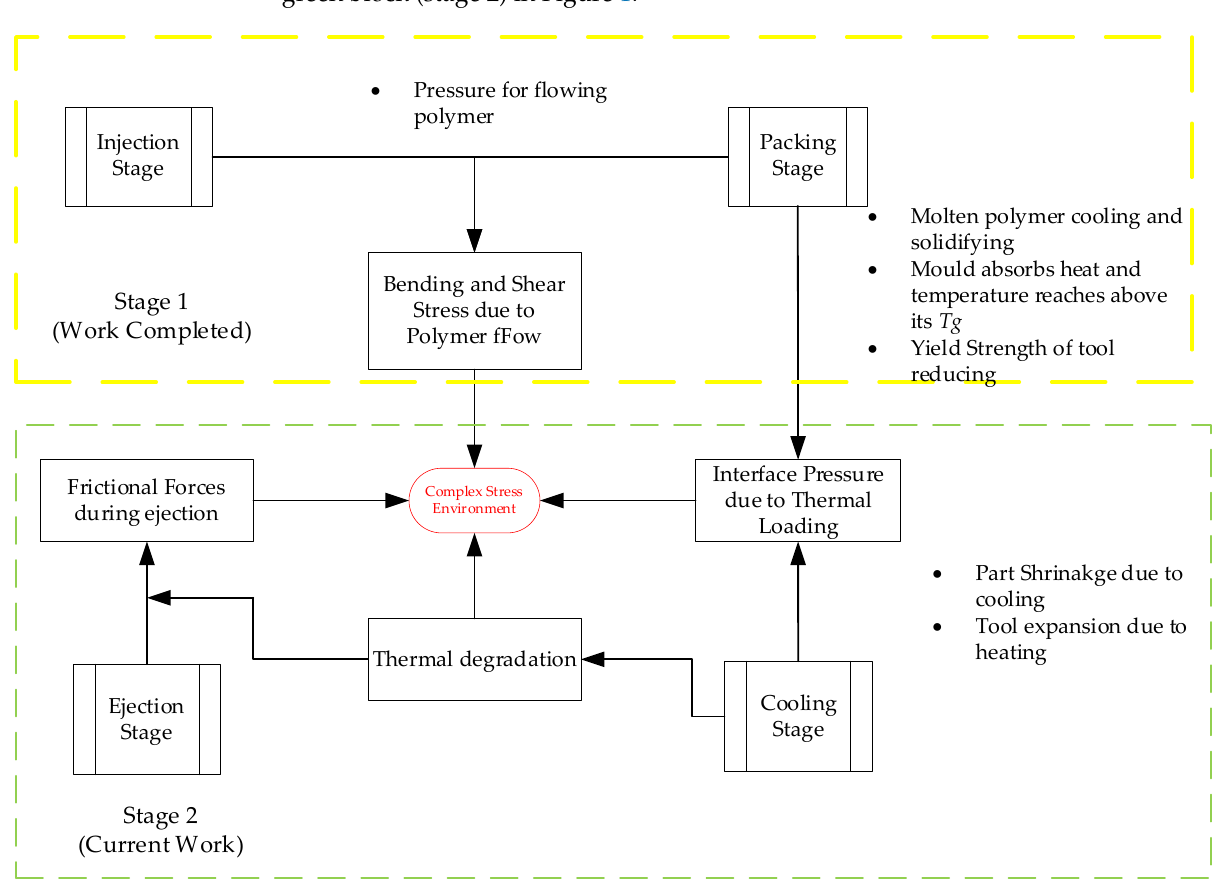
Figure 1. Complex stress environment on 3DIM during different injection moulding stages.